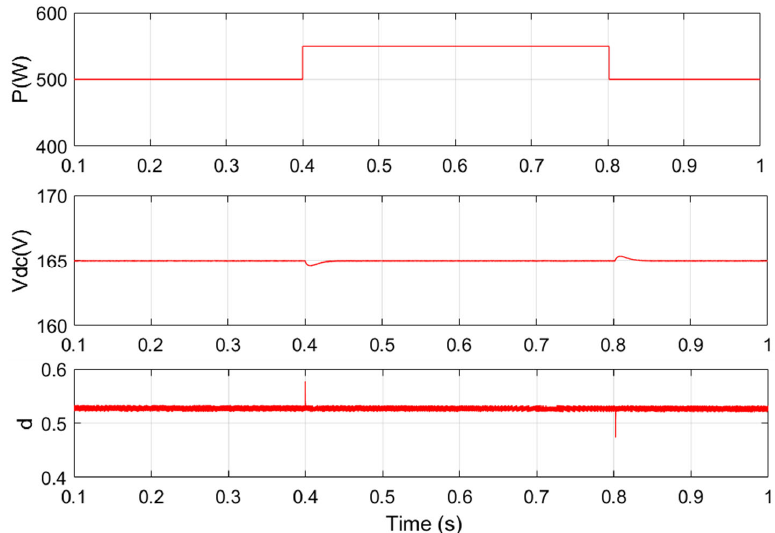
Figure 5. Simulation results with small CPL power variation.